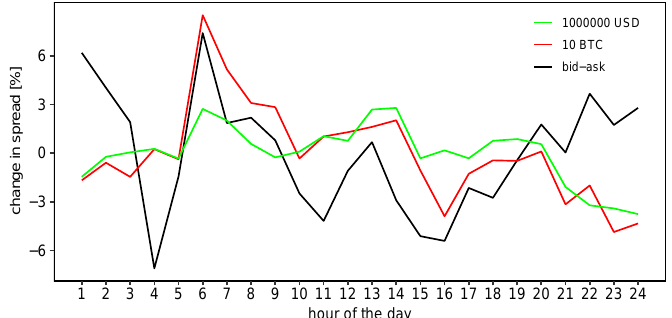
Figure 7. Intraday dynamics of liquidity costs. We display the relative deviation from the mean value of the average hourly distribution of the bid-ask spread ˜ s ( t ) and liquidity costs ˜ vs ( ω , t ) for 10BTC and 10 6 USD, with the hour of the day given in the local exchange time zone (Hong Kong time). Robustness checks: As expected, the observed average hourly changes in liquidity are not robust when considering subperiods of data, which supports the conclusion of absent intraday